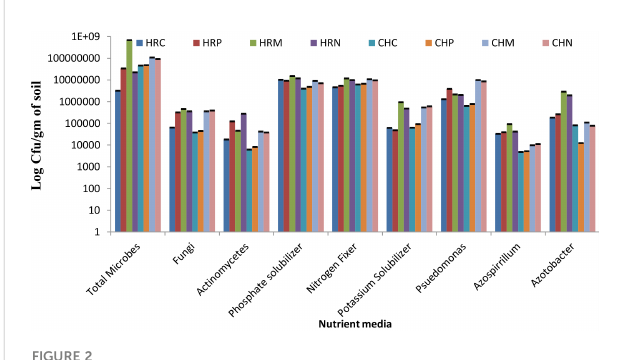
FIGURE 2 Culturable bacterial counts (cfu/g dry weight soil) of Chakrata and Harsil soils on different nutrient media. HRP, Harsil Pre-sowing Soil, HRC, Harsil control soil, HRM, Harsil MP1 treated soil, HRN, Harsil N26 Treated soil, CHP, Chakrata Pre-sowing soil, CHC, Chakrata control soil, CHM, Chakrata MP1 treated soil, CHN, Chakrata N26 Treated